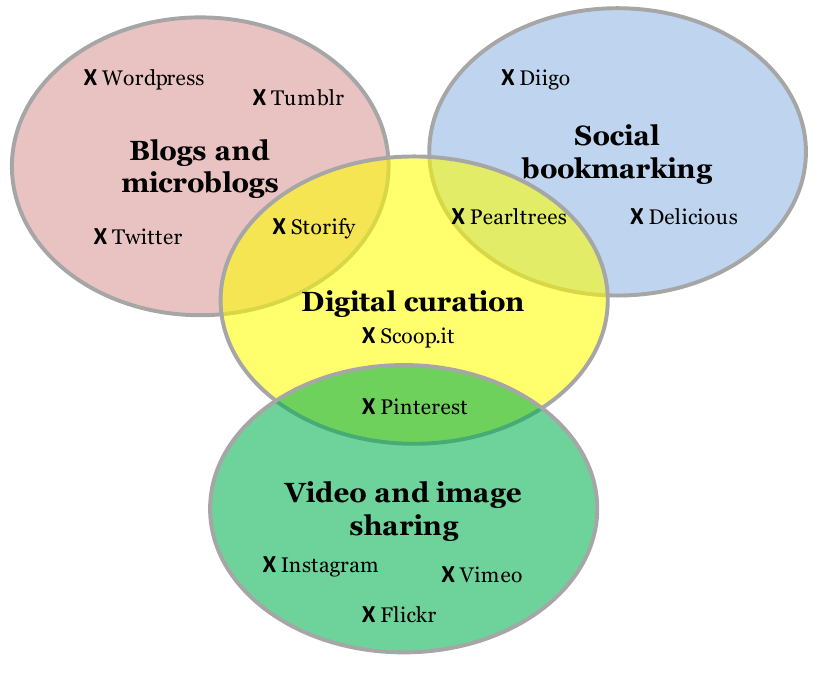
Figure 1 . Digital curation tools (Antonio et al.,